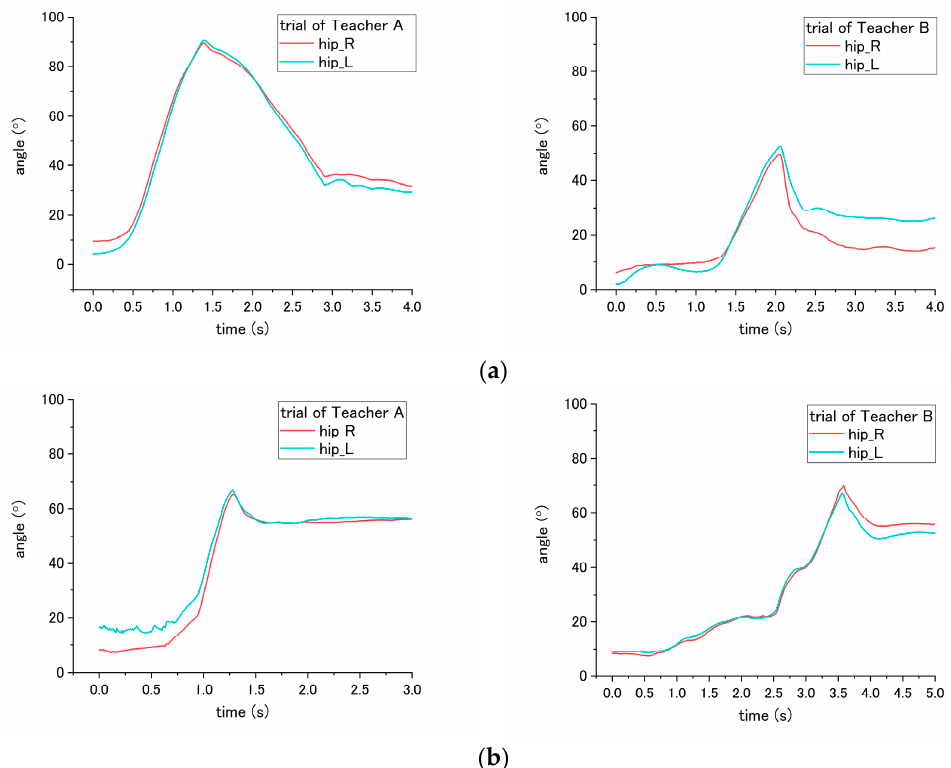
Figure 21. Flexion angle of patient’s hip during step No. 15 when the ( a ) correct way, and ( b ) incorrect way were conducted at step No. 15.